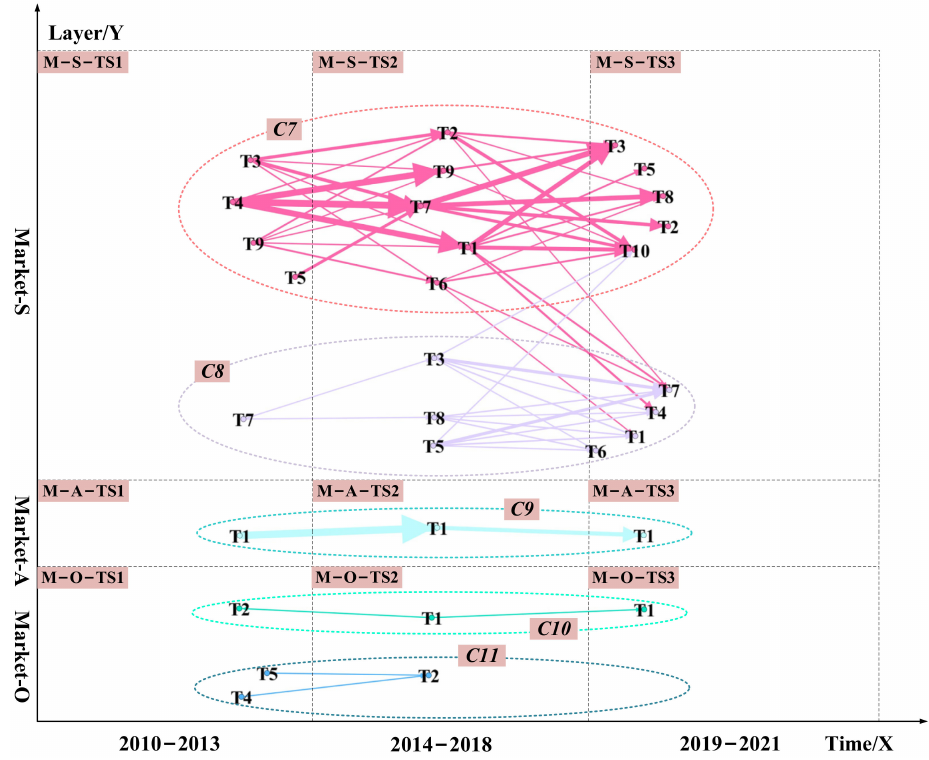
Figure 7. The data-driven TRM for the market layer. The marketing layer was divided into five communities represented by C 7 , C 8 , C 9 , C 10 , and C 11 . Dashed cycles with different colors highlight diverse communities. The edges’ width and arrows’ width represent the probability of a potential link between unconnected nodes. The wider the edges and arrows, the higher the likelihood of a potential link. Arrows and edges with different colors represent different community